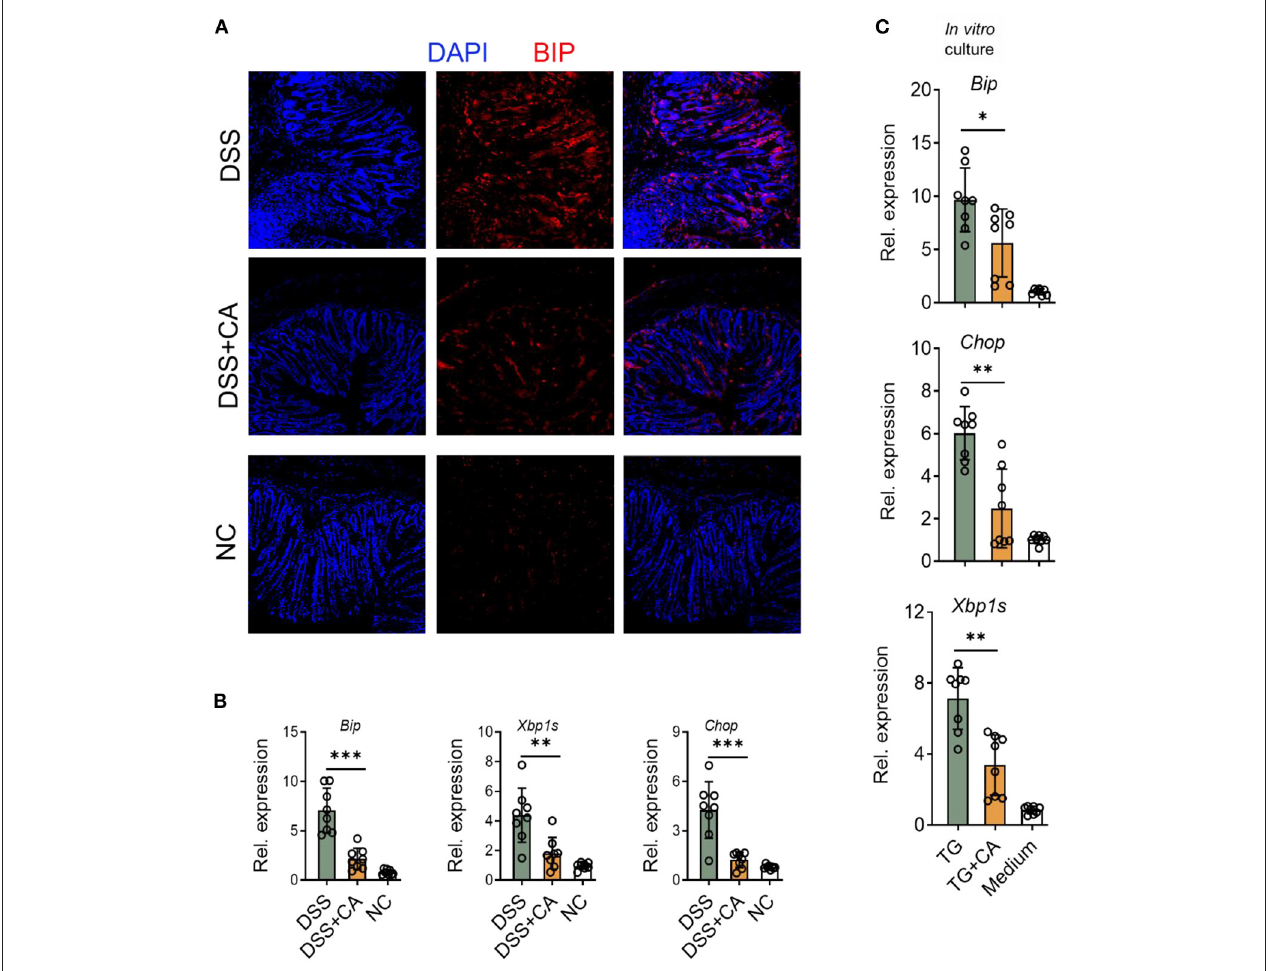
FIGURE 6 | CA suppresses ER stress in IEC. Colitis was induced as described in Figure 1 and colon samples were collected on day 10. (A) Colonic sections were stained for BIP and DAPI. Representative immunofluorescence images are shown. (B) The expression levels of BIP, XBP1s, and CHOP were determined by qRT-PCR. (C) HCT-116 cells (an intestinal epithelial cell line) were incubated overnight with Thapsigargin (TG, 100nM) in the presence or absence of CA (10 µ M). The expression levels of BIP, CHOP, and XBP1s were determined by qRT-PCR. Data are presented as mean ± SD. Representative data of three independent experiments are shown. One-way analysis of variance (ANOVA) followed by Tukey’s multiple comparisons test, * p < 0.05, ** p < 0.01, and *** p <